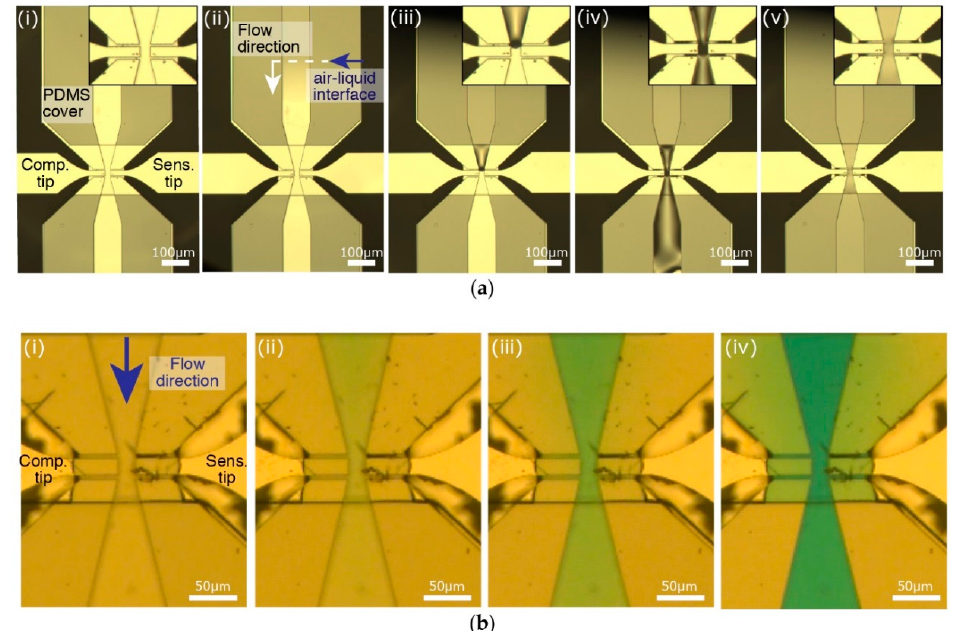
Figure 7. ( a ) After assembling the PDMS cover on the MEMS device (i); the formed channel is filled with liquid. Adjusting the pressure with the pump, the liquid enters the channel (ii); reaches the opposing tips (iii); goes through the handling area (iv); and finally, completely fills the channels; ( b ) The liquid exchange capability of the device is tested with water and a blue dye solution. (i) While the channel is filled with water; (ii,iii) a blue dye solution is injected at the inlet and within seconds (iv) the liquid in the channel is completely replaced.